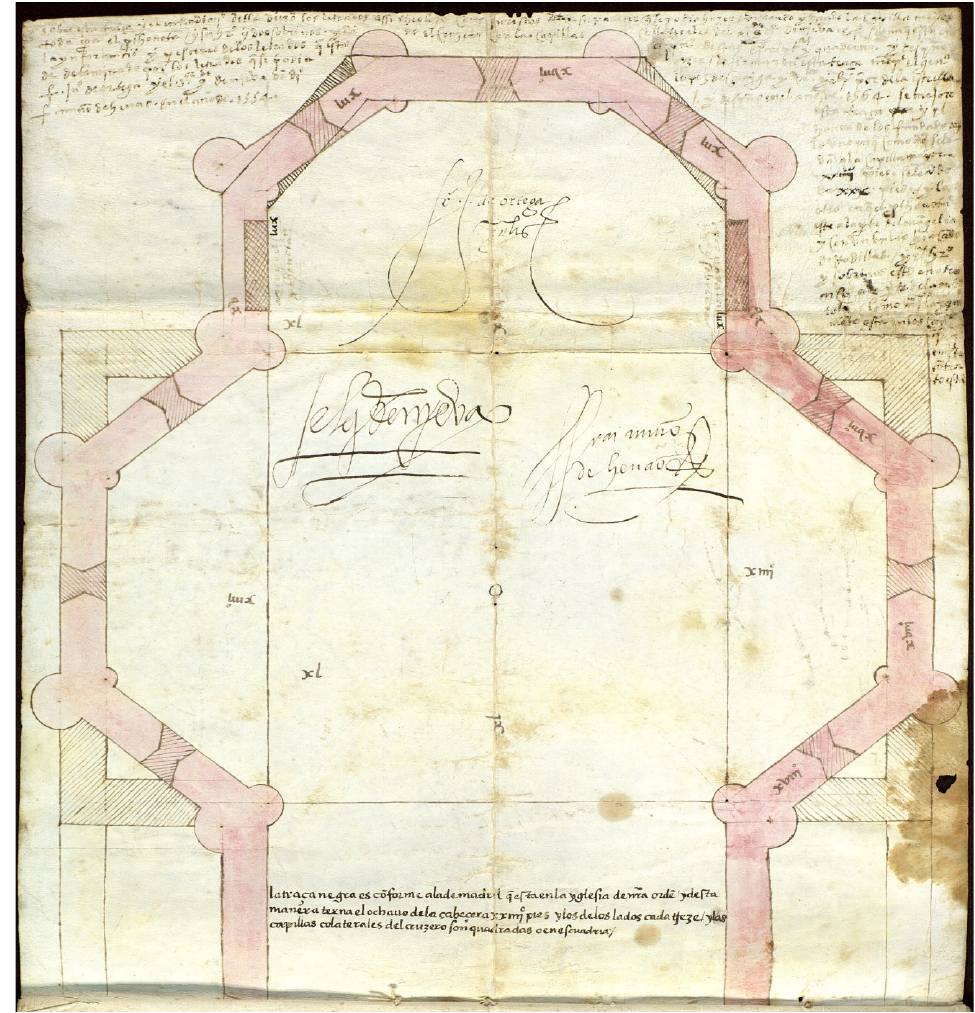
Figure 12. Corrected proposal for the east end of the church of the Hieronymite monastery of Santa María de la Estrella (La Rioja) [A.H.N., Sección Clero Secular-Reg- Mar í a de la Estrella (La Rioja) [A.H.N., Secci ó n Clero Secular-Regular, Carp. 1.062, 18]. © Archivo ular, Carp. 1.062, 18]. © Archivo Histórico Nacional. Hist ó rico